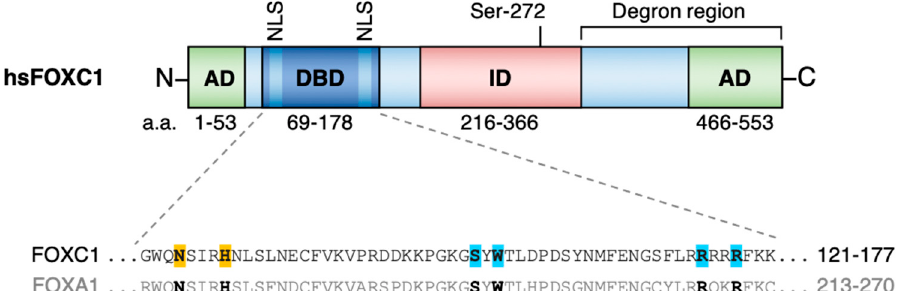
Figure 1. ( Above ) Overview of FOXC1 protein structure and functional protein domains identified by in vitro analyses. ( Below ) Amino acid sequence alignment of critical residues in the Forkhead domain of FOXC1 which are essential for the DNA-binding properties of FOX proteins. Residues highlighted in orange are indispensable for sequence-specific recognition of the FOX DNA motif, while those highlighted in blue promote non-specific engagement of nucleosomal DNA by FOXA proteins, consistent with pioneer activity [10,11]. AD, activating domain; DBD, Forkhead DNA-binding domain; ID, inhibitory domain; NLS, nuclear localization signal; hs, Homo sapiens . The same studies also identified an inhibitory domain (ID) (a.a. 215–366). In contrast to the